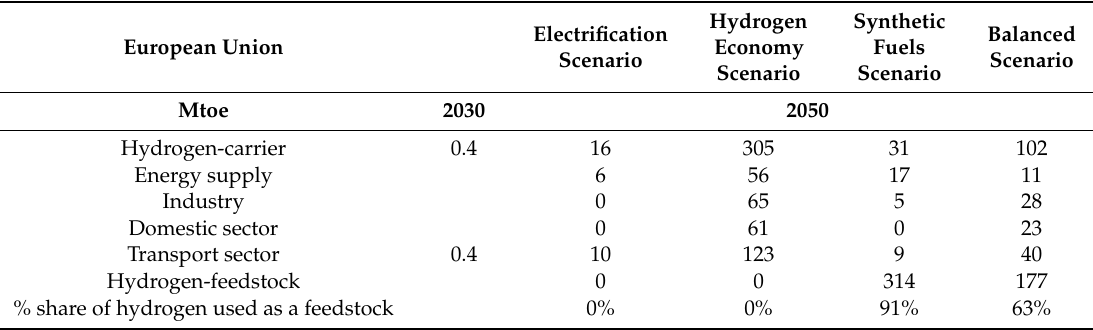
Table 6. Hydrogen utilization